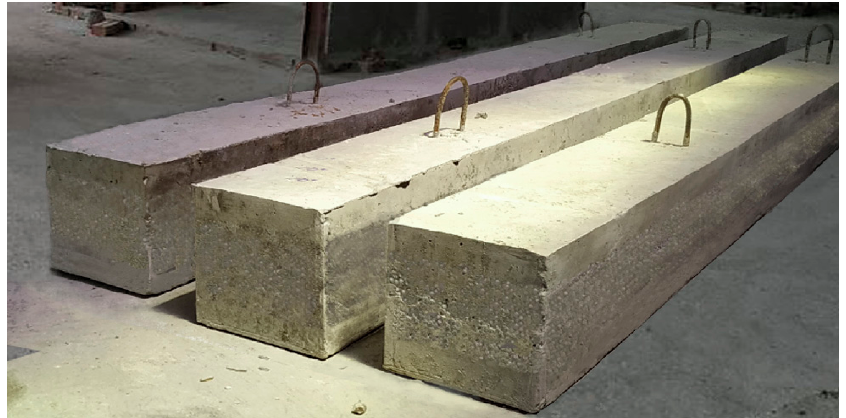
Figure 8. The samples of the tested beam in bending.